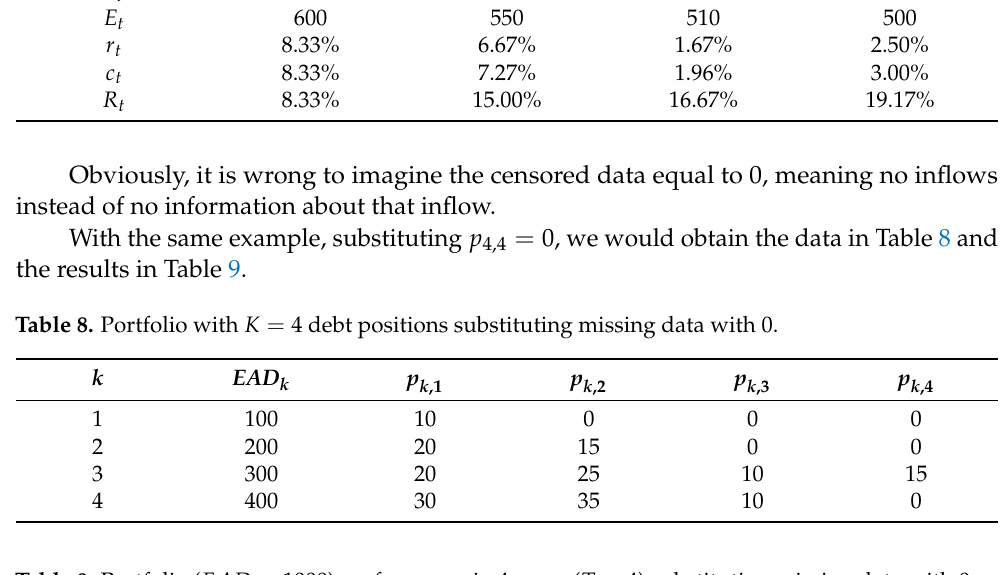
Table 9. Portfolio ( EAD = 1000) performance in 4 years ( T = 4) substituting missing data with 0.